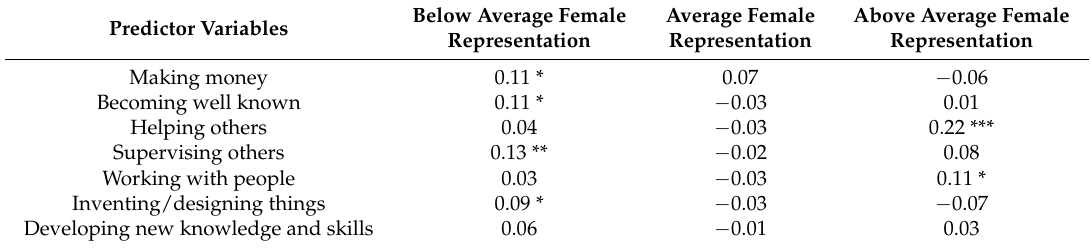
Table 4. Standardized Estimates of Multiple Regression Analysis for Factors for Career Outcome Expectations. Predictor Variables